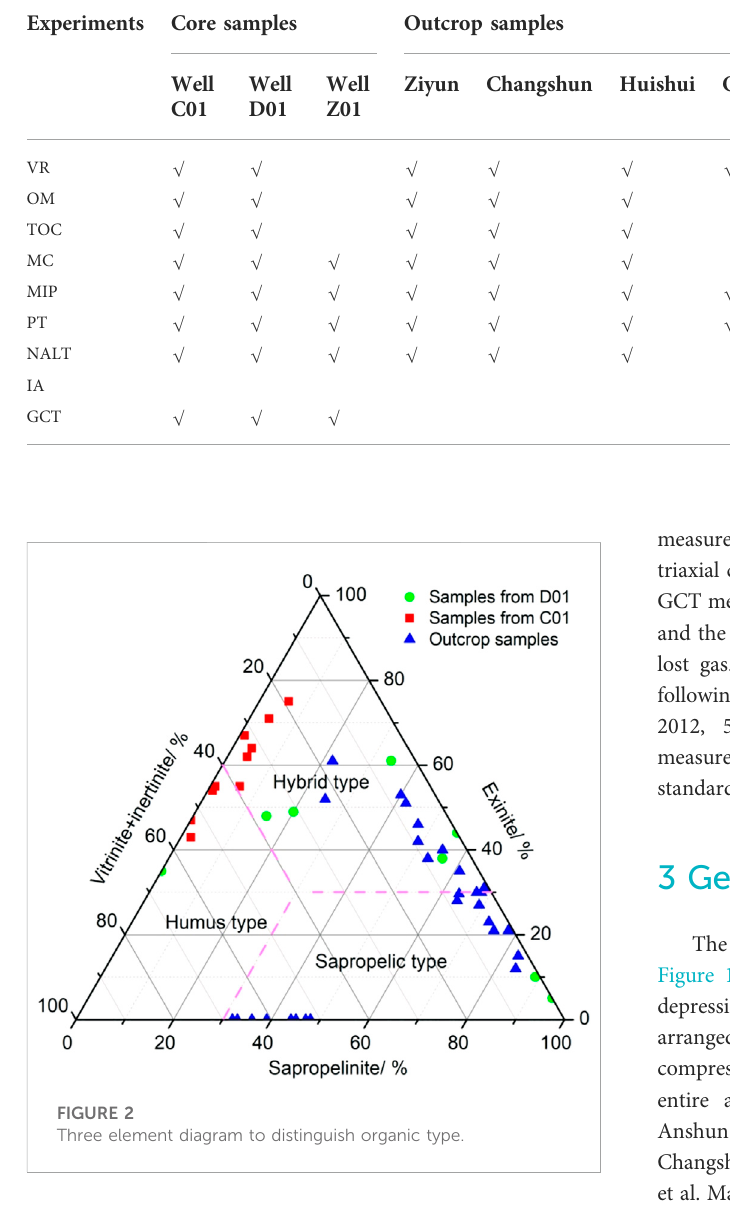
TABLE 1 Samples used in each experiment.